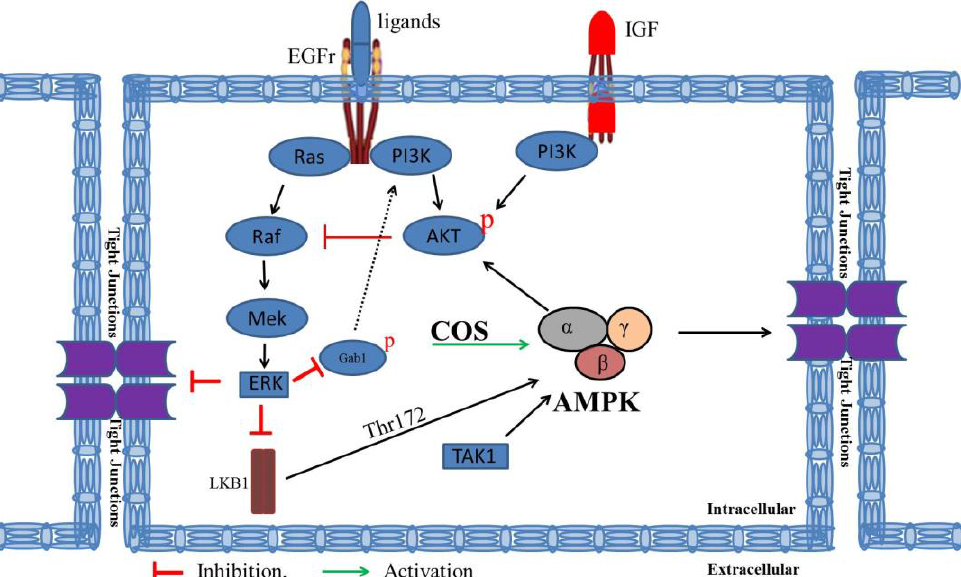
Figure 8. Schematic model summarizing the barrier junction integrity induced by COS via regulating the intricate interplay between PI3K/AKT and MAPK/ERK signaling. AMPK is an essential regulator for AKT activation under stress conditions. AMPK is activated by phosphorylation of AMPK- α subunit at threonine-172 (Thr-172). Moreover, AKT is activated by direct activation of EGFr through ligand binding. High stimulation of insulin growth factor (IGF) also activates AKT through its phosphorylation. Activated AKT inhibits the activity of Raf with concomitant inhibition of ERK. In addition, AKT signaling is negatively regulated by ERK activation. Firstly, EGF-induced ERK activation decreases the phosphorylation of Gab1 and inhibits the association of Gab1 with PI3K, an upstream of AKT signaling. Secondly, ERK activation by mitogens inhibits LKB1, which is an upstream regulator of AMPK signaling.